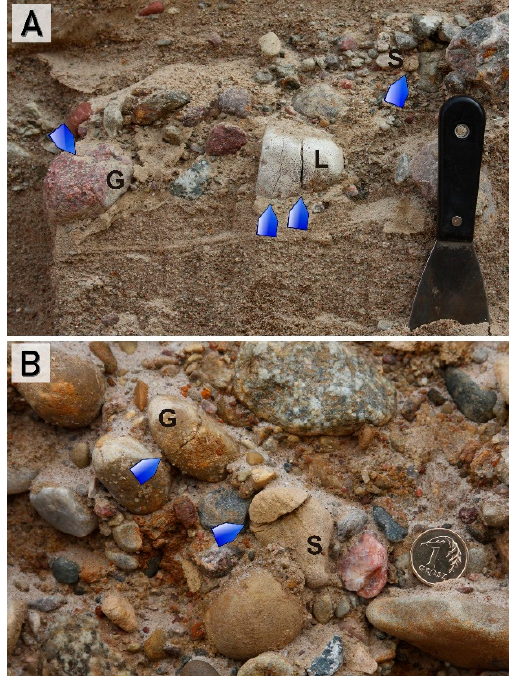
Figure 5. Examples of fractured clasts: ( A ) from exposure 1, ( B ) from exposure 3 ; G—granite; L—limestone; S—sandstone.